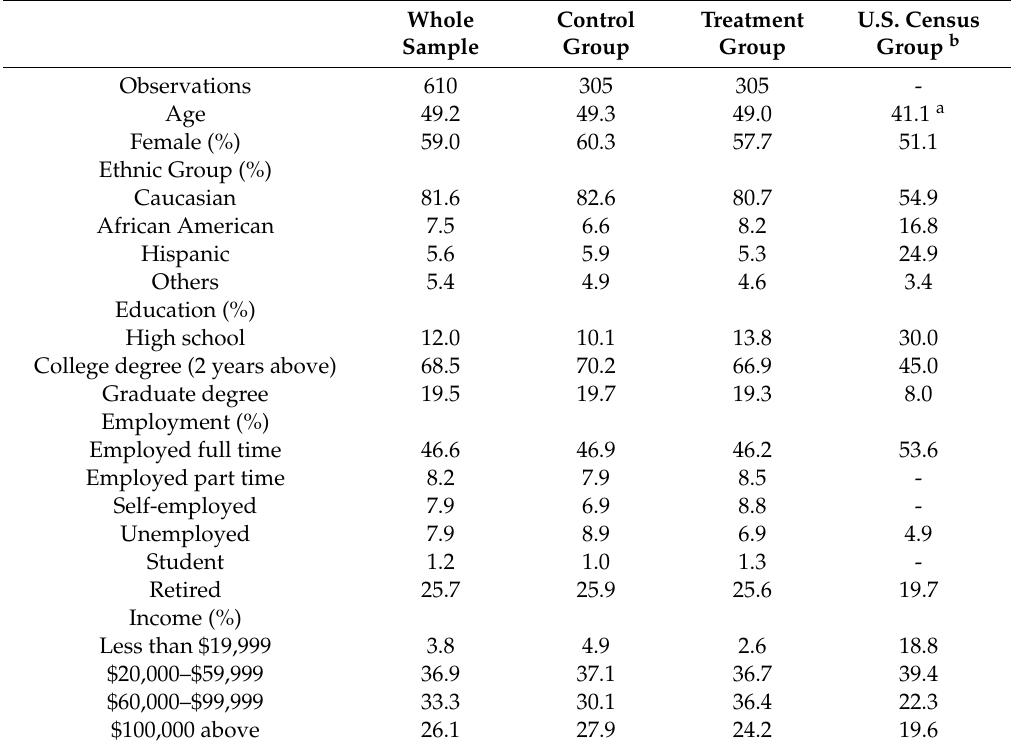
Table 2. Summary statistics of socio-demographics